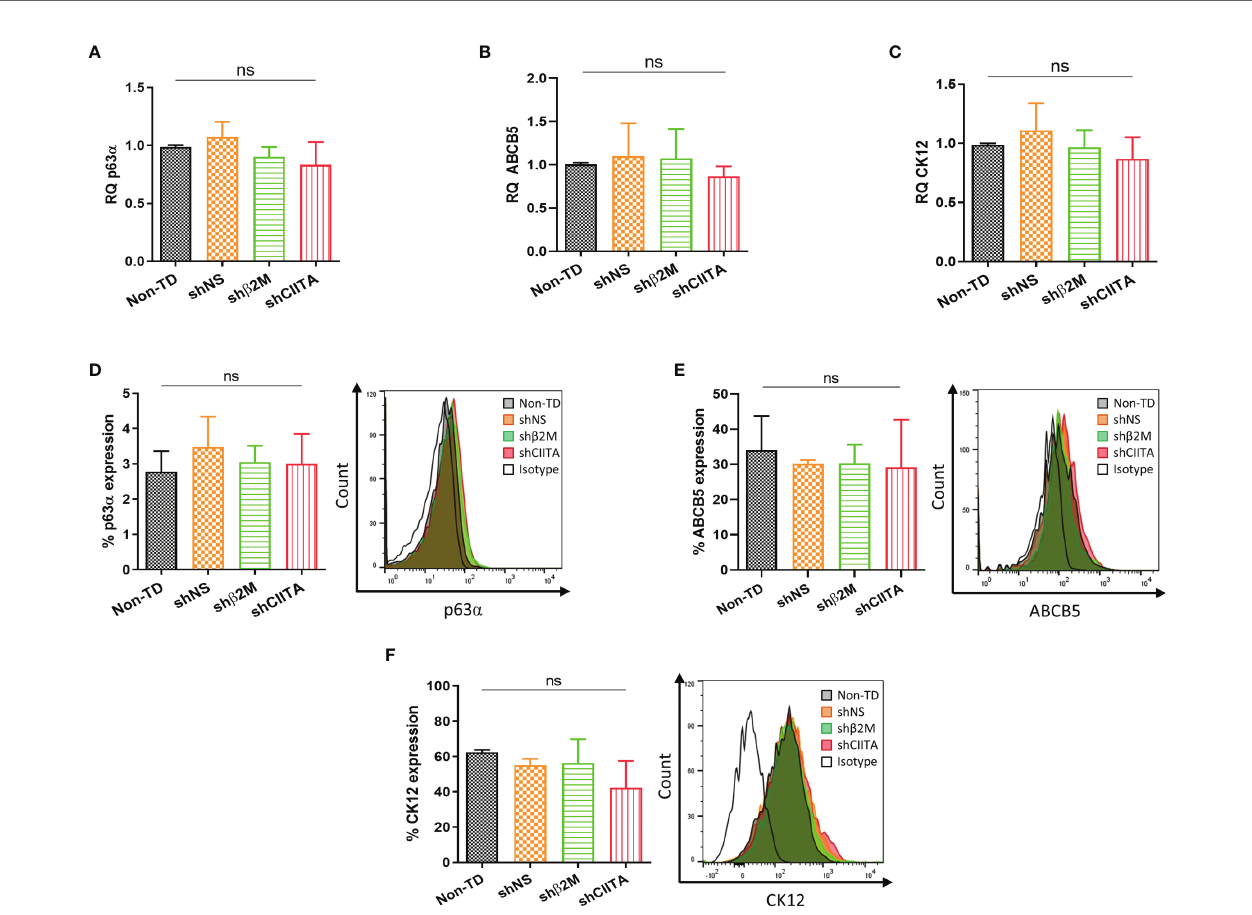
FIGURE 3 | Genetic engineering does not alter Limbal stem cell phenotype. (A – C) Transcripts levels of p63 a , ABCB5 and CK12 markers of non-transduced LSCs (Non-TD, n=4); non-silenced LSCs (shNS, n=4); b 2M-silenced LSCs (sh b 2M, n=4) and CIITA-silenced LSCs (shCIITA, n=4). (D – F) p63 a , ABCB5 and CK12 protein expression remains similar after HLA class I and class II downregulation. Statistical analysis was performed by one-way ANOVA and data are presented as mean ± SD, ns, no signi fi